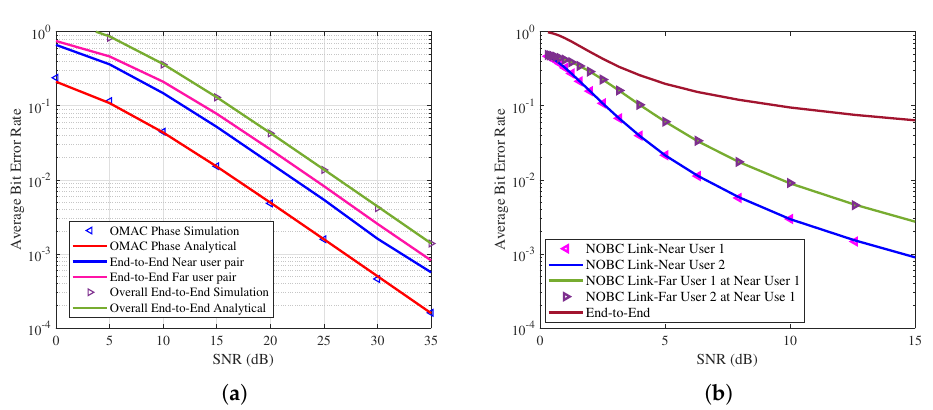
Figure 6. ( a ) Average BER performance of the proposed wireless network with perfect SIC. ( b ) Aver- age BER performance of the proposed wireless network in the presence of the